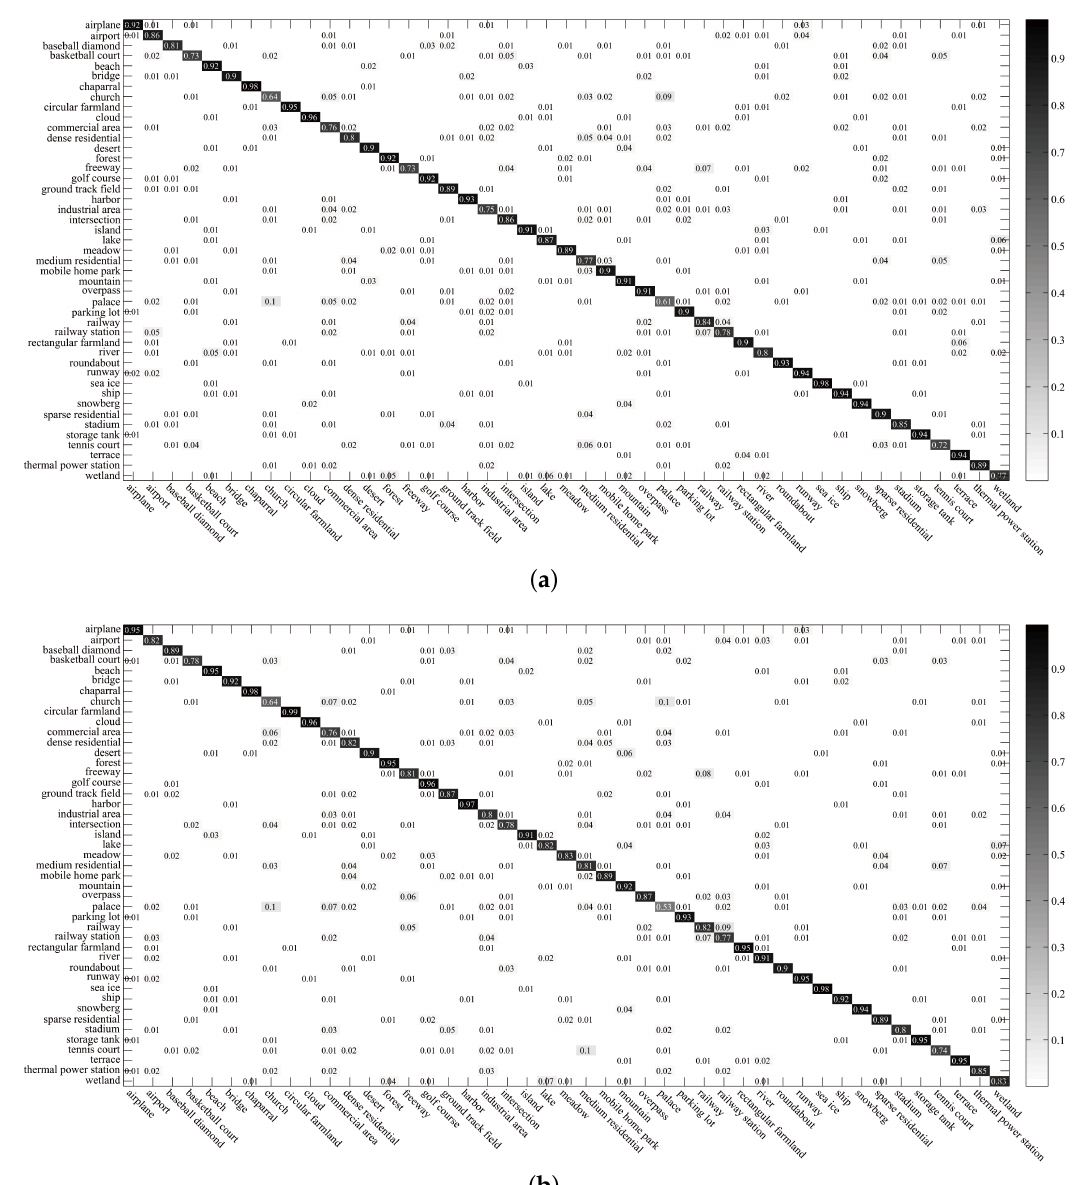
Figure 13. Confusion matrixes of the NWPU-RESISC45 dataset under the training ratio of 20% using the following methods. ( a ) texture coded two-stream architecture with our proposed fusion model; ( b ) saliency coded two-stream architecture with our proposed fusion